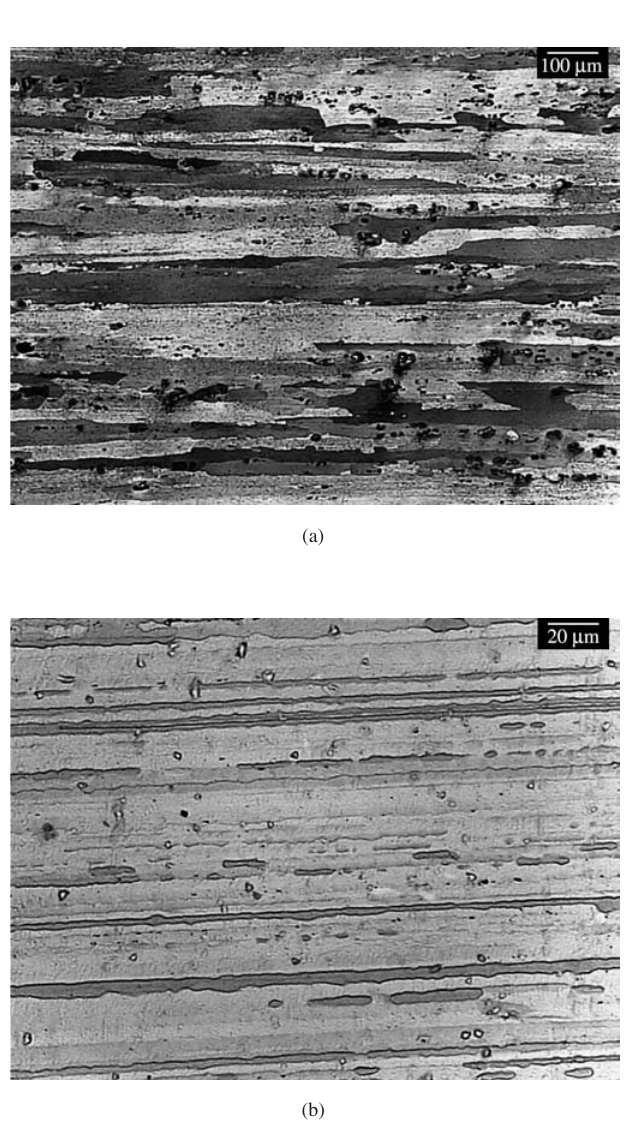
Figure 2. Optical micrographs, a) Al 2024 (100X); and b) Al 8090 (500X). Keller’s etching 17 .